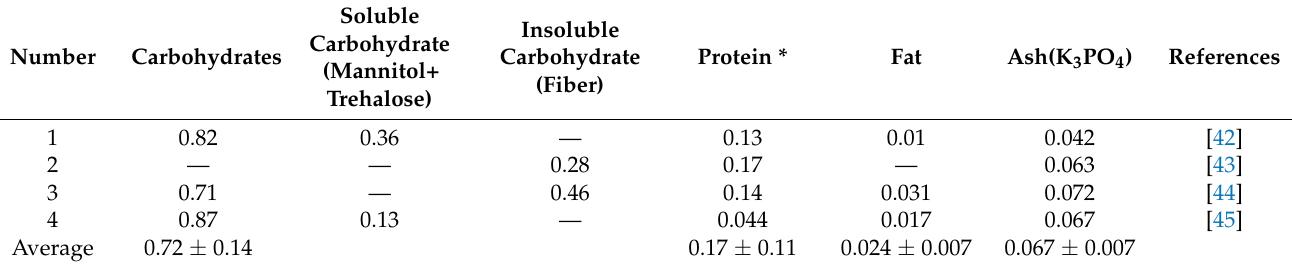
Table 2. Fraction of ingredients in dry matter of shiitake